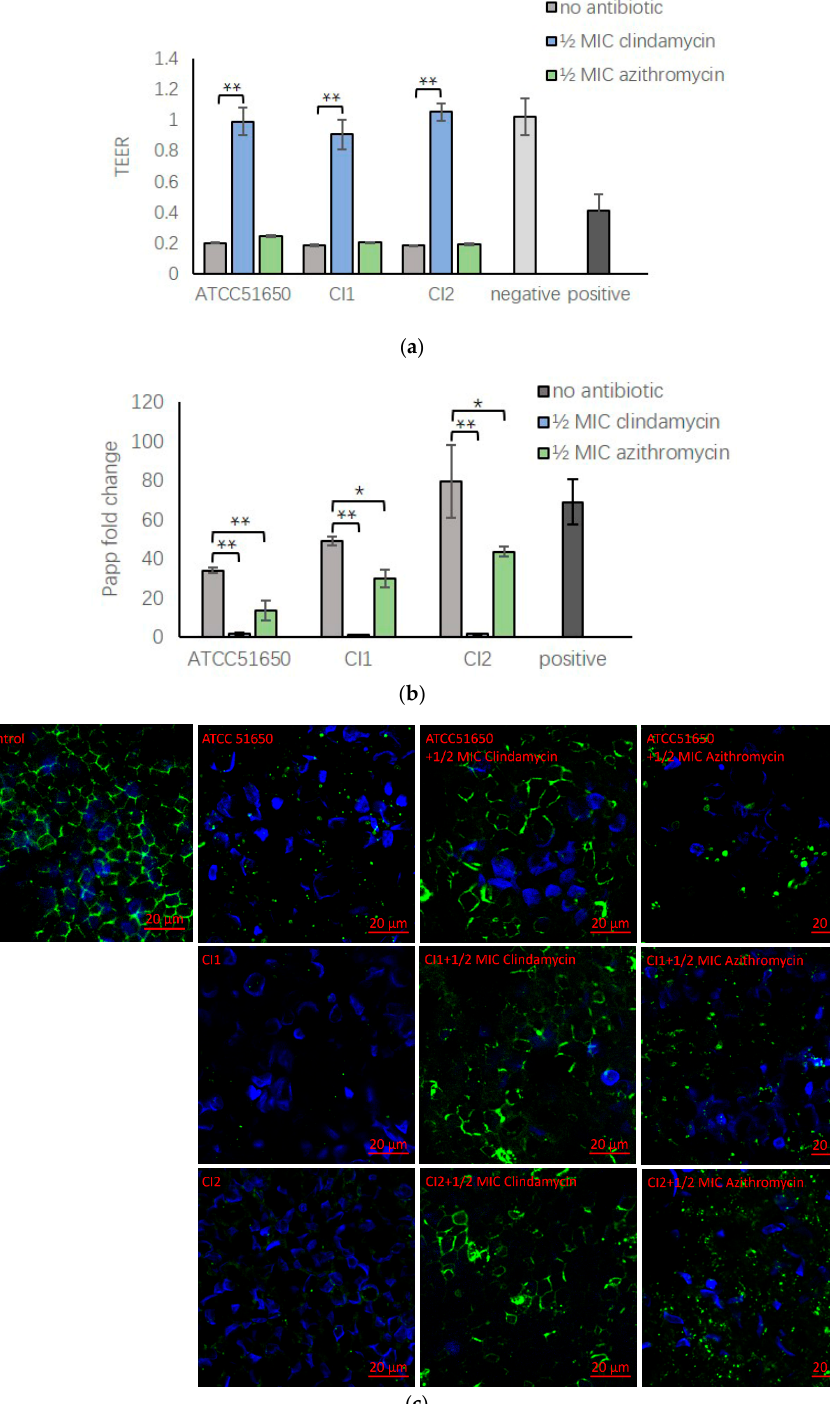
Figure 7. Transepithelial electrical resistance, relative permeability and immunofluorescence staining of S. aureus exoproteins treated HNEC-ALI cultures. ( a,b ) ½ MIC clindamycin significantly reversed the TEER decrease ( a ) and the increased HNEC-ALI permeability of FITC-dextrans induced by S. aureus ATCC 51650, CI1 and CI2 ( b ). ( c ) Immunofluorescence staining of ZO-1 (green) in HNEC-ALI cultures treated with medium (control) or exoproteins from ATCC 51650, CI1 and CI2 left untreated or treated with ½ MIC clindamycin or ½ MIC azithromyxin. DAPI stains nuclei blue. * p < 0.05, ** p < 0.01. n = 3.